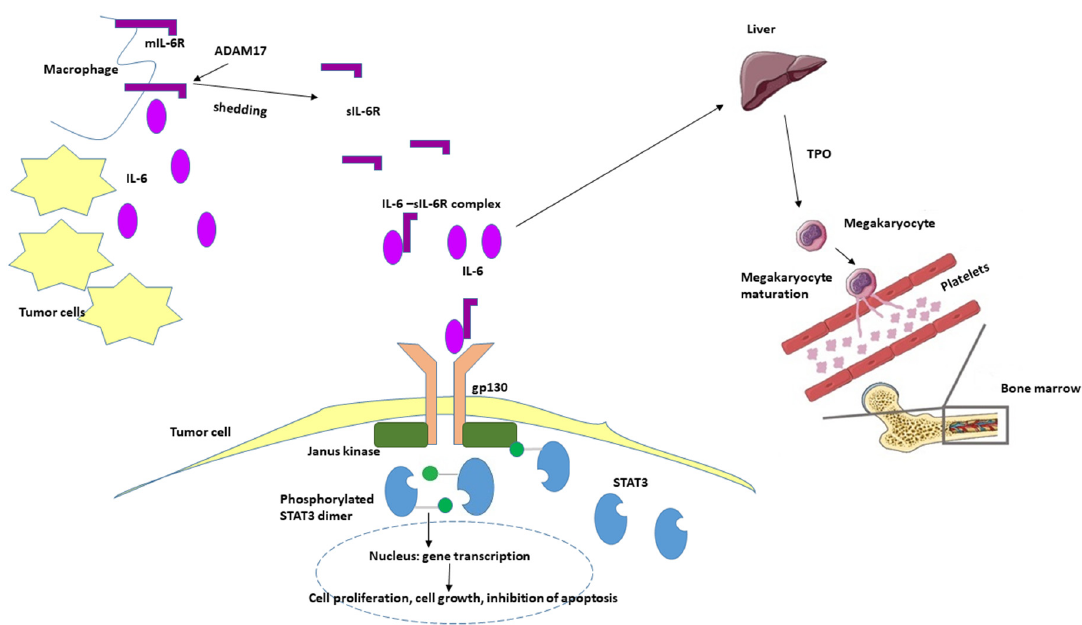
Figure 9. Hypothetical role of IL-6 in oncogenesis and tumor-associated thrombocytosis. IL-6 is produced in the tumor microenvironment both by mononuclear and tumor cells. Elevated levels of IL-6 induce thrombopoietin production in the liver, which in turn activates the maturation of megakaryocytes and the production of platelets resulting elevated platelet count. Simultaneously, IL-6 binds to the soluble form of IL-6 receptor (sIL-6R) and activates the gp130/JAK/STAT3 pathway leading to the translocation of phosphorylated STAT3 homodimer to the nucleus in the tumor cells and to the transcription of different genes inducing proliferation, cell growth and the inhibition of apoptosis. mIL-6R—membrane-bound IL-6 receptor, TPO—thrombopoietin, ADAM17—a disintegrin and metalloproteinase 17; STAT3—signal transducer and activator transcription 3.